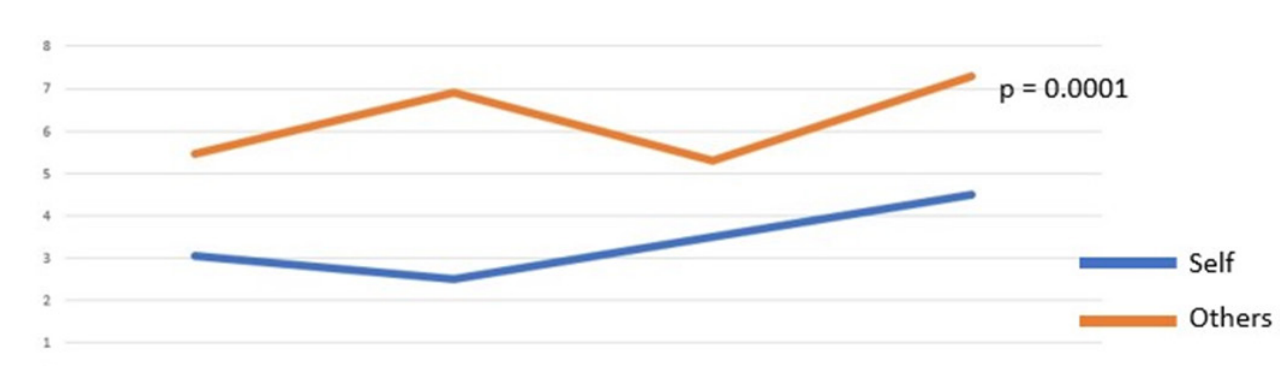
Fig. 2 - Obstruction of goals according to self-judgments and judgments for